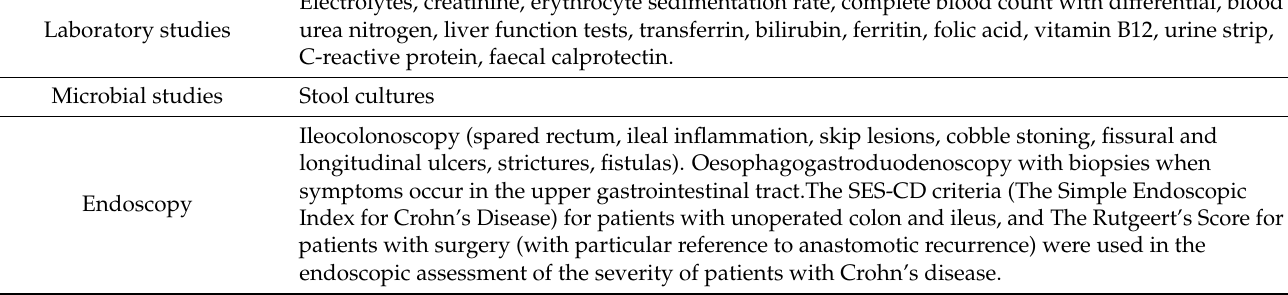
Table 1. Summary of diagnostic